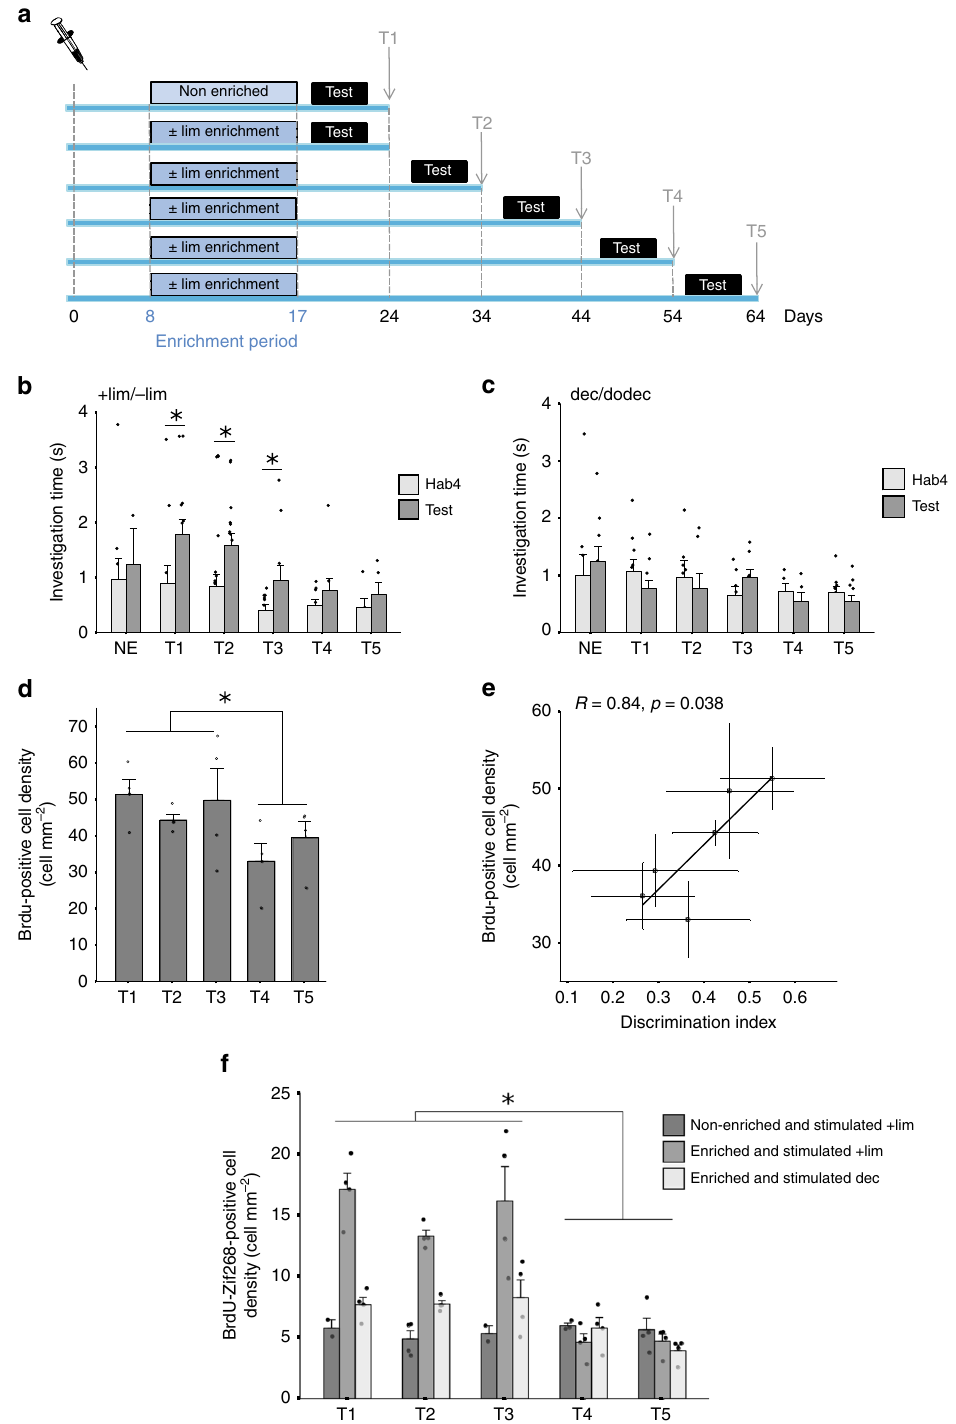
Fig. 1 The presence of adult-born neurons correlates with mnesic performance. a Experimental design. b – f Behavioral results. b Discrimination between + lim and -lim is assessed at different time points after the enrichment period. Non-enriched control (NE; n = 9) animals do not discriminate the + lim from − lim at T1. After enrichment, the two odorants are discriminated at T1 ( n = 11), T2 ( n = 5), and T3 ( n = 10) but not at T4 ( n = 9) and T5 ( n = 5). c Dec and dodec are not discriminated at any time post-learning (NE n = 9; T1 n = 10; T2 n = 7; T3 n = 8; T4 n = 5; T5 n = 10) (for clearer representation, 1 data point belonging to the Test trial of the NE group is not shown (investigation time = 6s)). T -test, * p < 0.05. d Adult-born neuron density in the OB in enriched experimental groups. Groups that discriminated + lim/ − lim (T1 – T3) have a higher BrdU-positive cell density compared to groups that do not